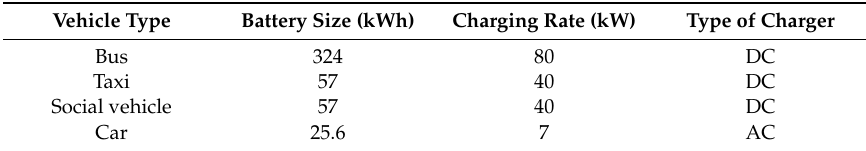
Table 1. Parameters of di ff erent types of electric